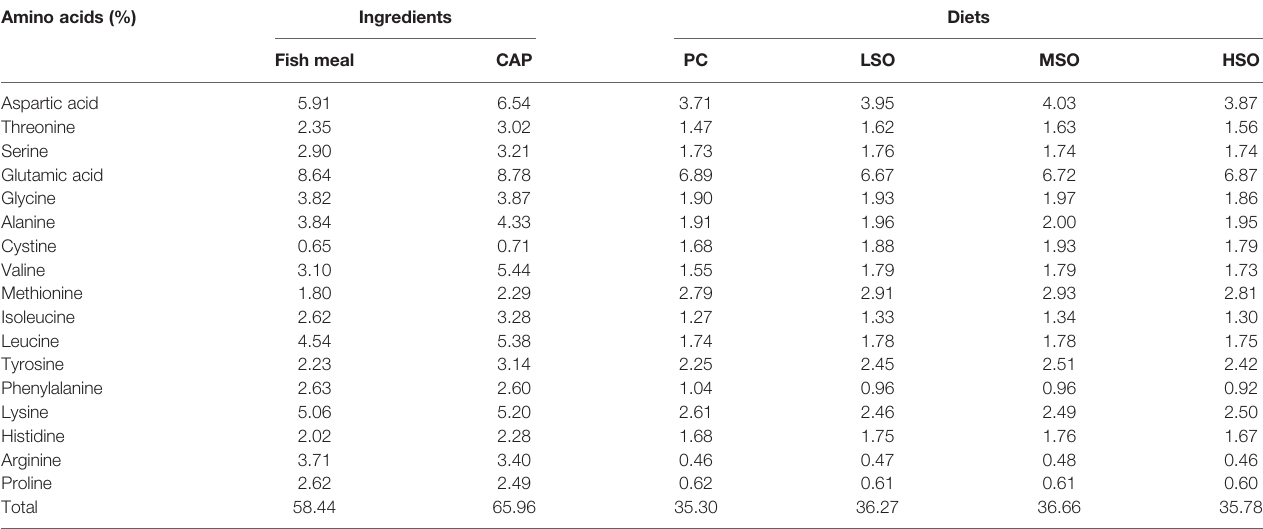
TABLE 2 | Amino acid compositions of ingredients and diets used in this study (dry matter basis). Amino acids (%) Ingredients Diets Fish